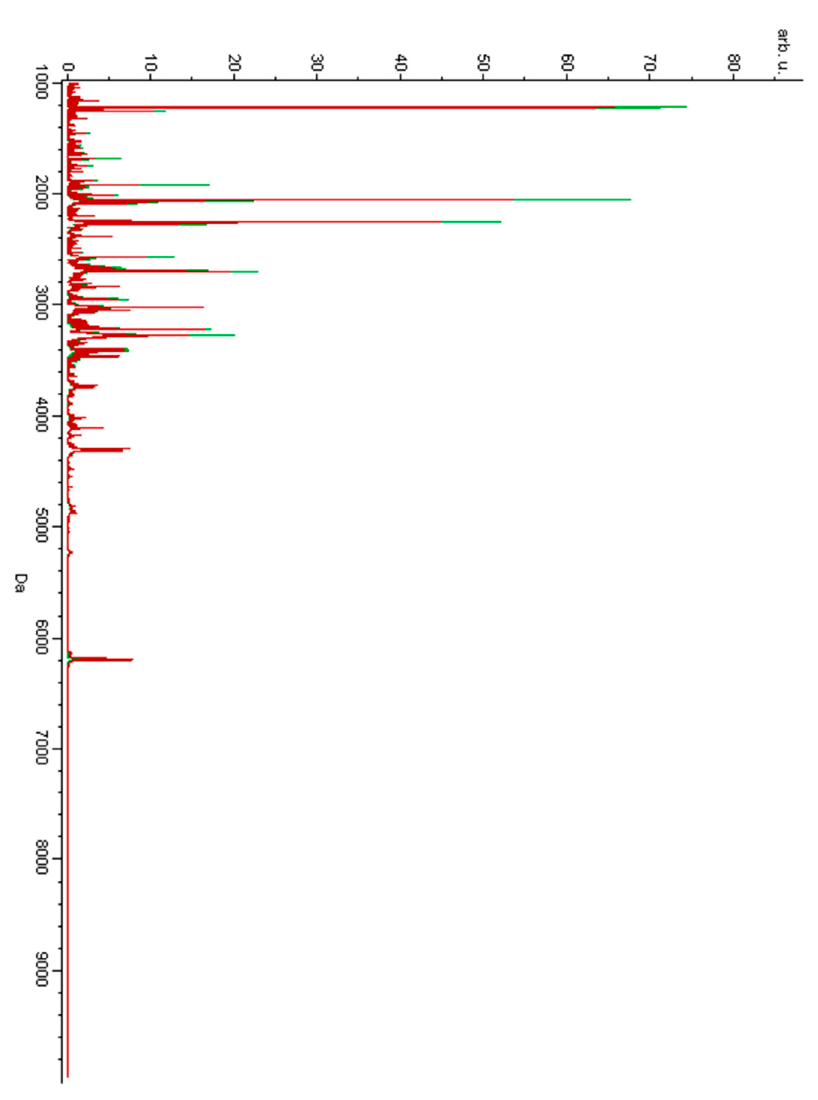
Figure 2. Average MALDI-TOF mass spectra of urine samples of the women suffering from GTN after treatment (red) and of the non-pregnant controls (green) over the full scan range of m/z 1000– 10,000.